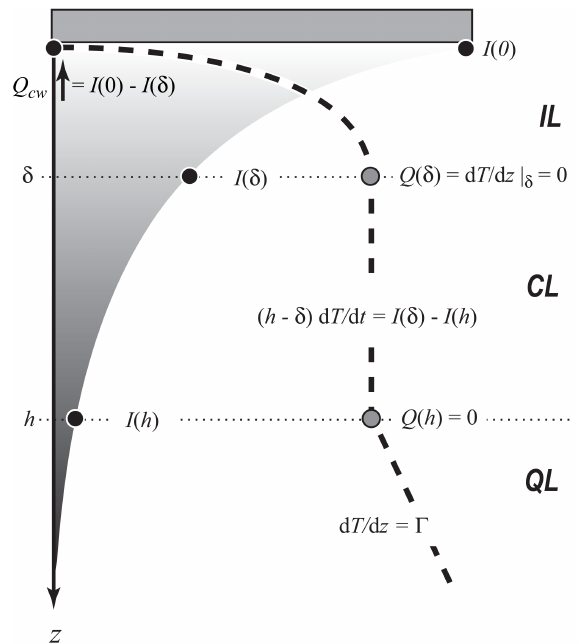
Figure 2. Schematic of the temperature structure of the under- ice water column illustrating the major assumptions under models (10)–(14) and (15)–(16).